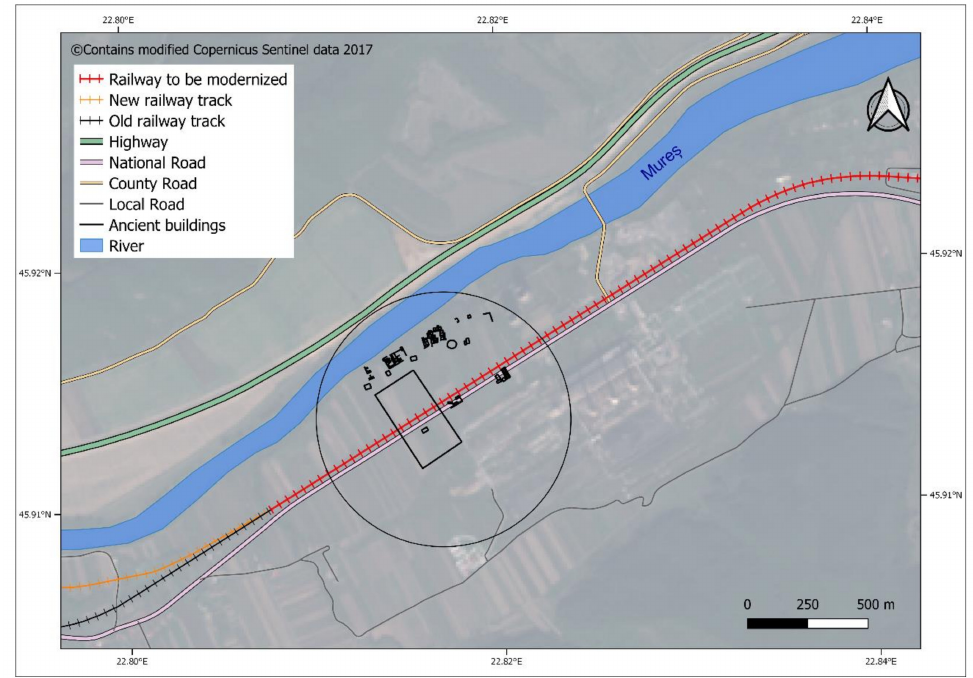
Figure 12. Micia archaeological site – the major infrastructure projects that cross the ruins of the ancient settlement (background image: Sentinel–2, RGB combination: B4–B3–B2 natural colours, 10 m